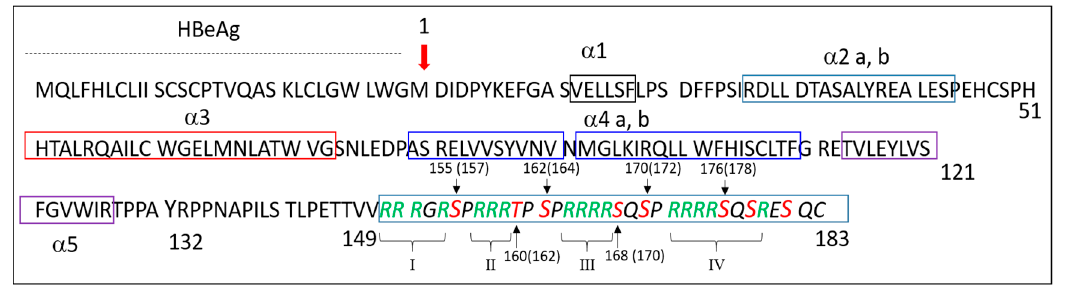
Figure 2. HBc primary sequence. HBc sequence starts at position M1. The upstream 29 residue sequence corresponds to a peptide signal that drives the translocation of the 25 kDa precore protein into the ER lumen, leading to the synthesis of a secreted form of the core protein, named HBeAg [23]. The N-terminal domain (NTD) corresponds to residues 1–140. Rectangles delineate the five alpha-helices of NTD found in NTD monomers that are essential for HBc to assemble in the icosahedral capsid [24]. The next ten residues contain the PPXA sequence found in various viral proteins to hijack the Endosomal sorting complexes required for transport machinery (ESCRT) [25,26]. This flexible sequence was recently confirmed to be essential during HBV replication. The C-terminal domain (CTD) contains arginine residues (in green) required for the interaction of HBc with nucleic acids (NAs), an activity that is regulated by the phosphorylation of the seven serine/threonine residues (in red), even though S 155, 162 and 170 are considered as the three major phosphorylation sites (residue numbers of S or T in brackets, genotype A).